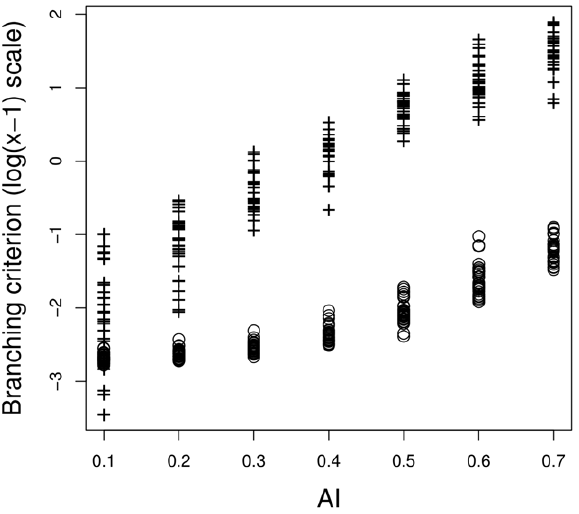
Figure 4. Value of the branching criterion against the aggregation index ( AI ). Open circles, situation A ( m s ~ 75% , d = s ~ 1 : 1 ( d ~{ b 1 ~ b 2 ~ 1 : 1 and s ~ 1 ) and p ~ 0 : 32 ); pluses, situation B ( m s ~ 15% , d = s ~ 1 : 1 ( d ~{ b 1 ~ b 2 ~ 1 : 1 and s ~ 1 ) and p ~ 0 : 16 ). The lattice environment was